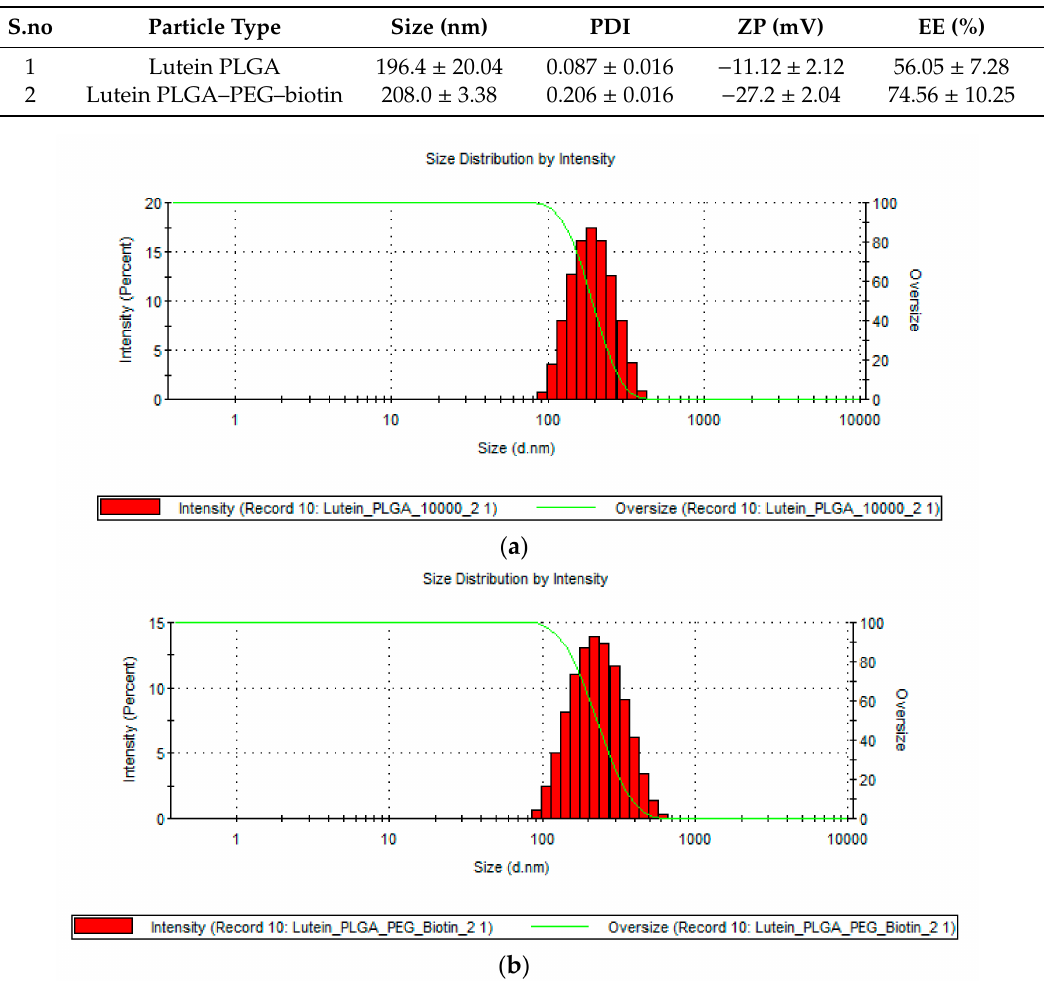
Table 1. Size, polydispersity index (PDI), zeta-potential (ZP), and encapsulation e ffi ciency (%EE) of lutein-loaded PLGA and PLGA–PEG–biotin nanoparticles (n = 3). Data are represented as means ± standard deviations (SDs).